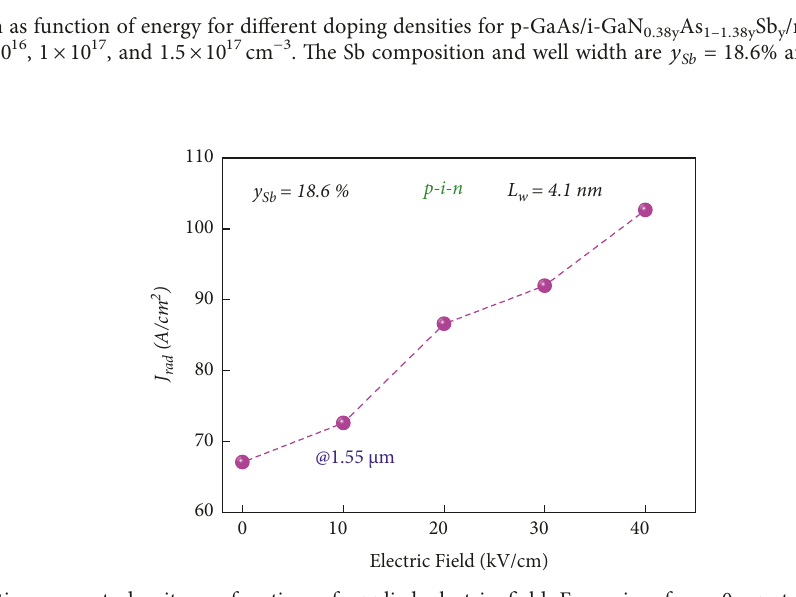
0.38y As 1–1.38y Sb y /n-GaAs QW laser structure